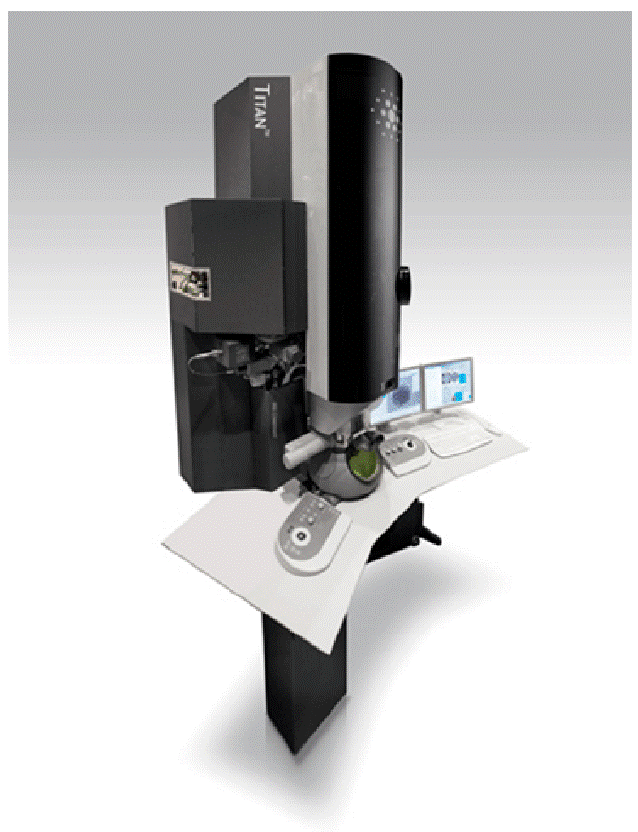
Figure 1: FEI Titan Titan G2 80-200 CREWLEY transmission electron microscope (photograph by cour- tesy of FEI